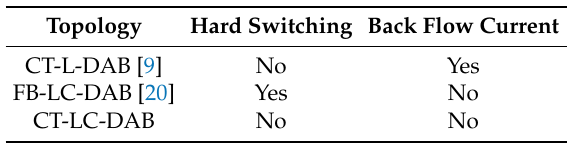
Table 1. Comparison between proposed topology and conventional